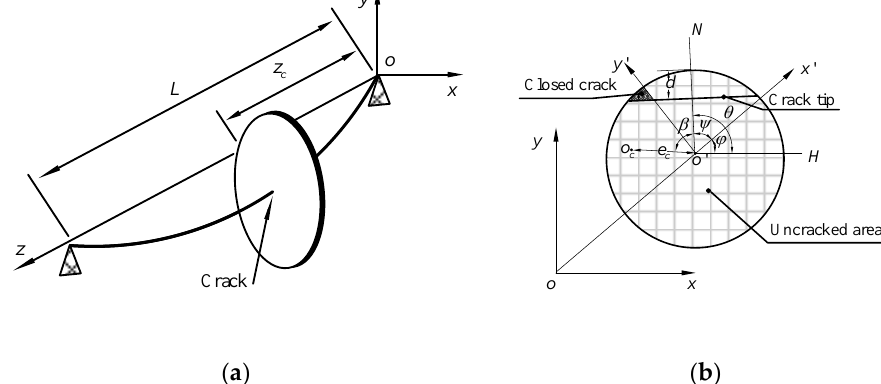
Figure 1. Schematic diagram of rotor system: ( a ) The Jeffcott rotor with a transverse crack, ( b ) schematic diagram of the cracked cross section.